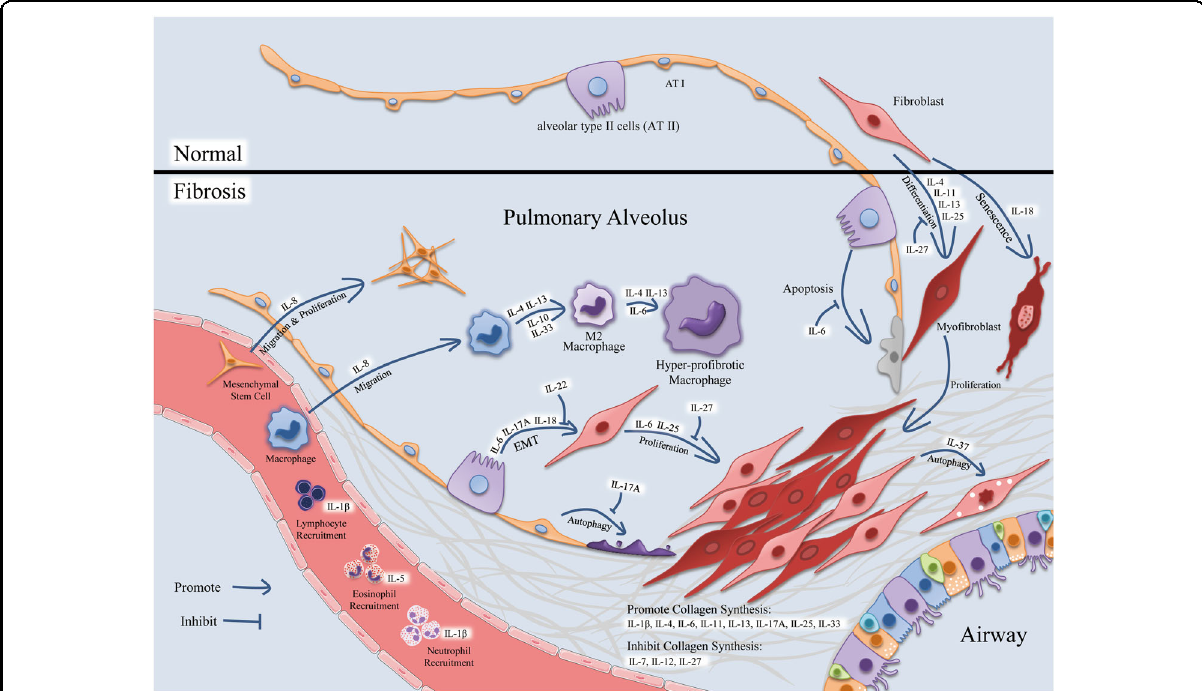
Fig. 1 Interleukins affect the morphology and functions of various cells in pulmonary fi brosis. (1) Mesenchymal stem cells: IL-8 facilitates the migration and proliferation of mesenchymal stem cells. (2) Macrophages: IL-8 also induces migration of macrophages. IL-4, IL-13, IL-10, and IL-33 promote macrophages to transform into M2 phenotype, which is further promoted by IL-4, IL-6, and IL-13 to transform into a hyper-pro fi brotic phenotype. (3) Other immune cells: IL-1 β induces recruitment of lymphocytes and neutrophils, while IL-5 induces recruitment of eosinophils. (4) Alveolar epithelial cells: IL-17A inhibits autophagy of alveolar epithelial cells, and IL-6 suppresses apoptosis of alveolar type II cells (AT II). IL-6, IL-17A, and IL-18 promote EMT of AT II, whereas IL-22 inhibits this process. (5) Fibroblasts: IL-6 and IL-25 promote the proliferation of fi broblasts. IL-4, IL-11, IL- 13, and IL-25 induce differentiation of fi broblasts, whereas IL-27 suppresses both events. IL-18 contributes to the senescence of fi broblasts, and IL-37 facilitates autophagy of fi broblasts. IL-1 β , IL-4, IL-6, IL-11, IL-13, IL-17A, IL-25, and IL-33 promote collagen synthesis, while IL-7, IL-12, and IL-27 inhibit collagen